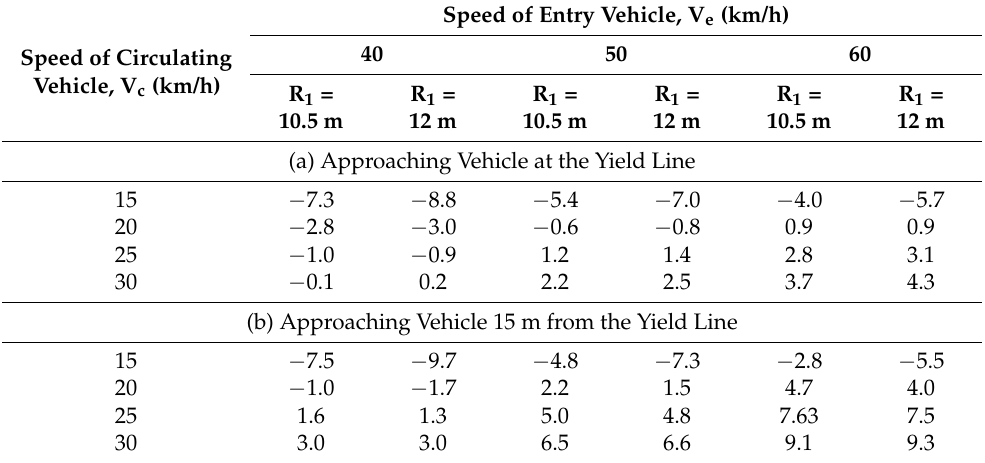
Table 5. Approximate maximum lateral clearance (m) for conflicting-entering vehicle (Approach 2).